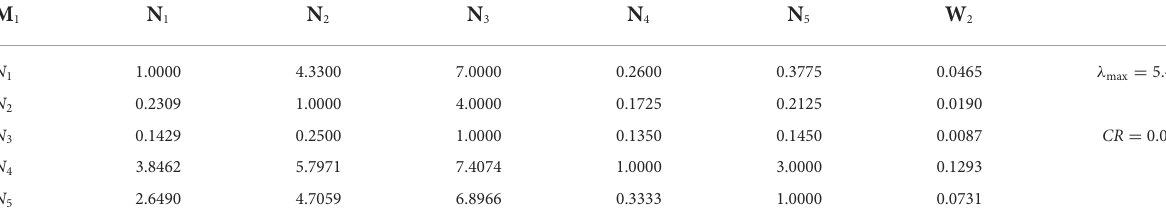
TABLE 5 Consistency ratio of HCI criterion judgment matrix and its weights.